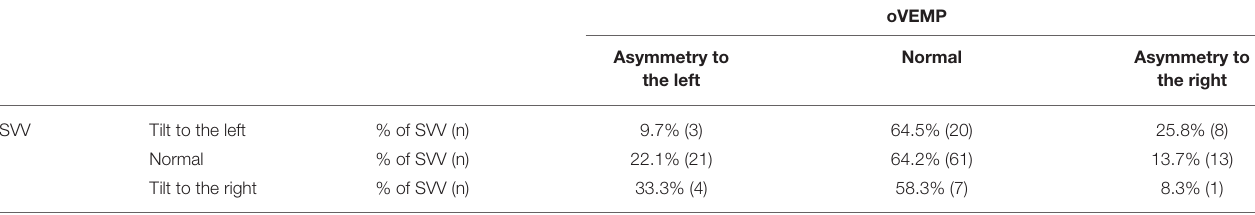
TABLE 1 | Cross table of SVV and oVEMP.